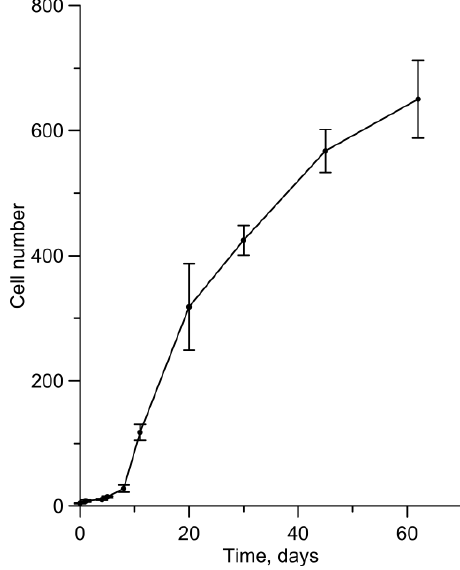
Figure 1. Growth of E . cf. paludosa cells during 62 days.